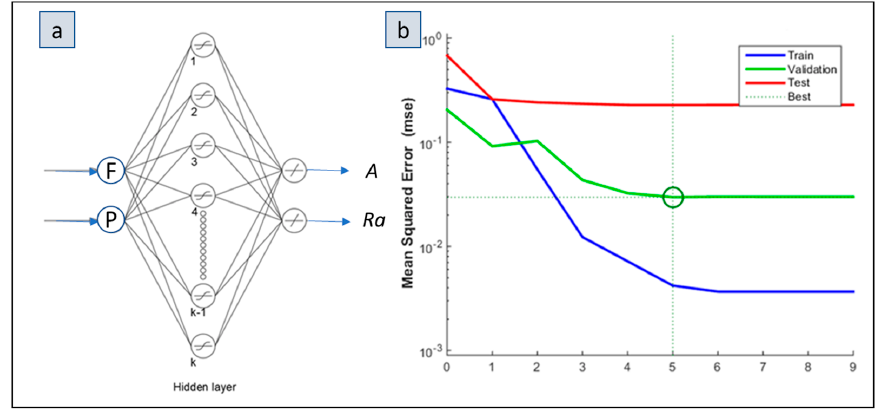
Figure 6. ( a ) Graphical illustration of the ANN architecture; ( b ) ANN validation performance.